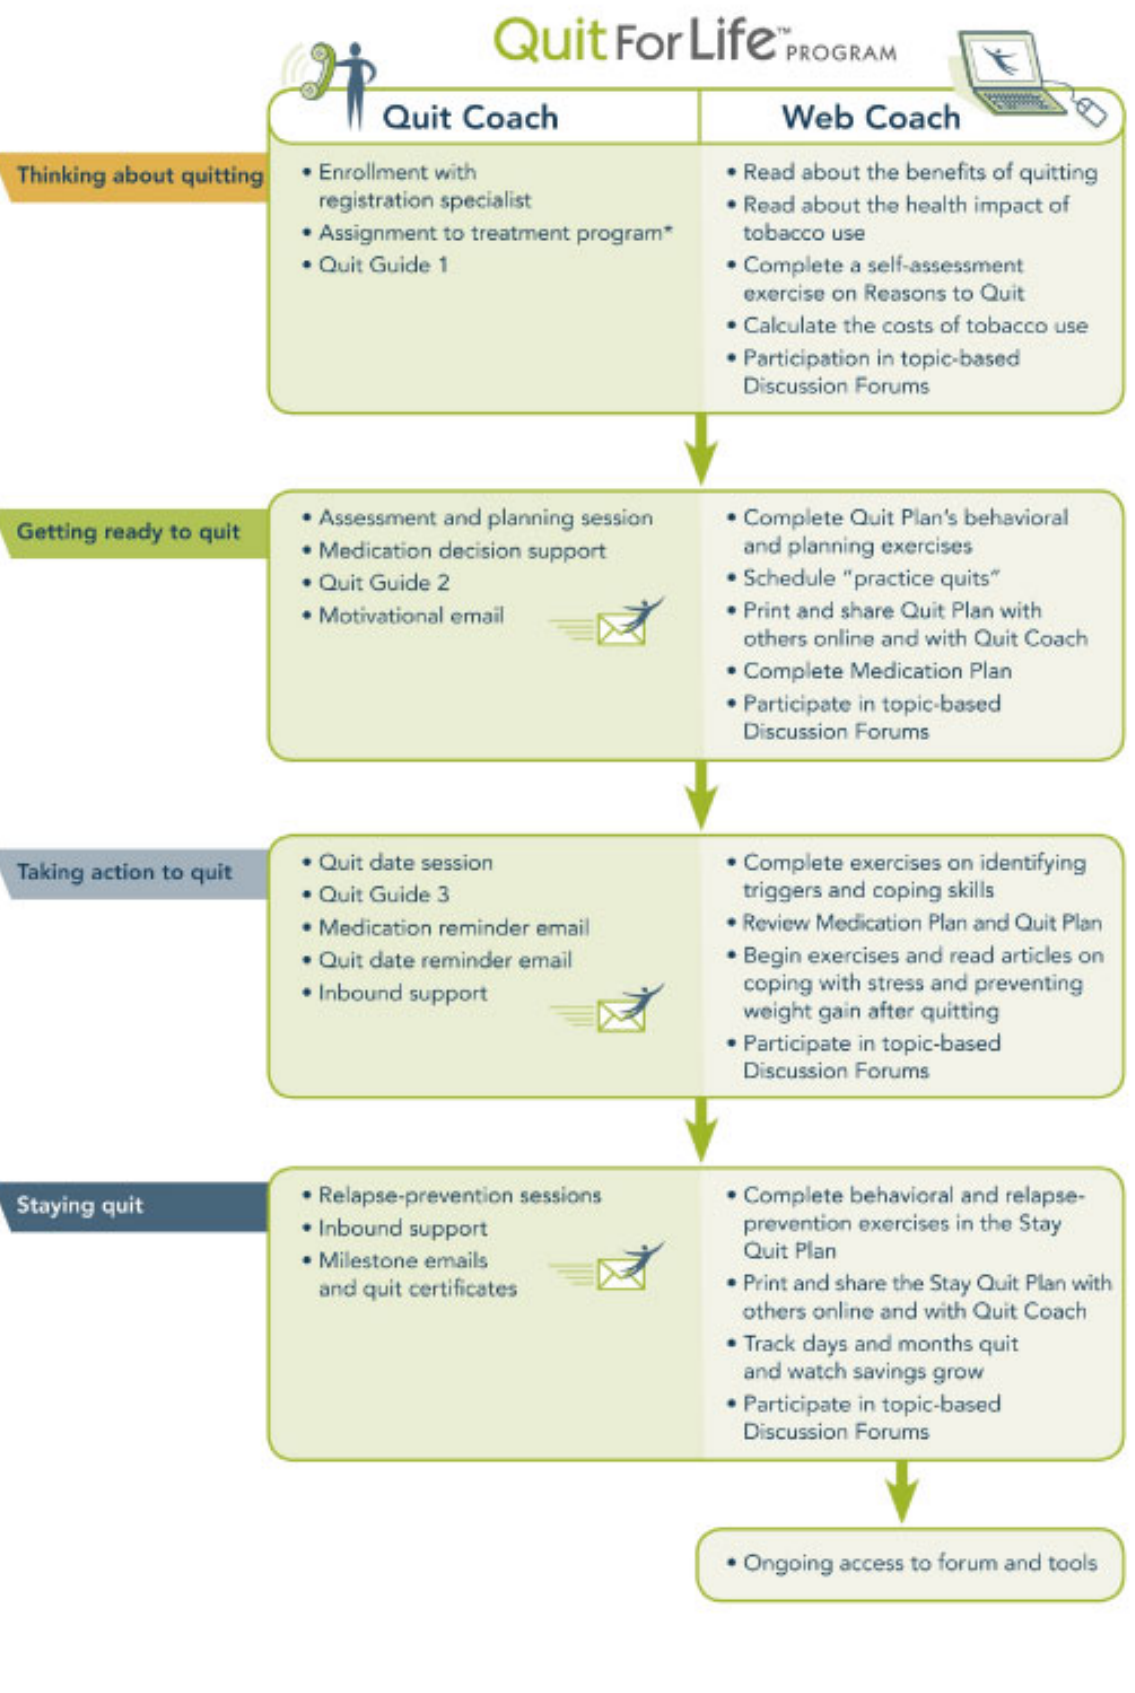
Figure 1. Interaction between the participant, Quit Coach, and Web